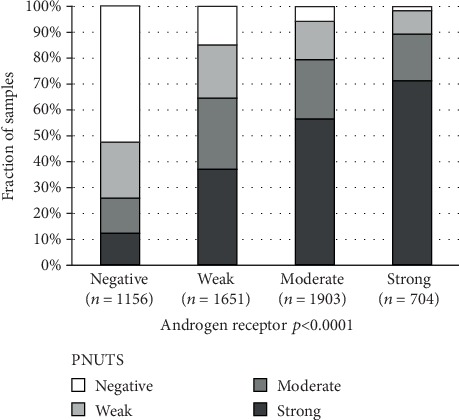
PNUTS staining and androgen receptor expression.